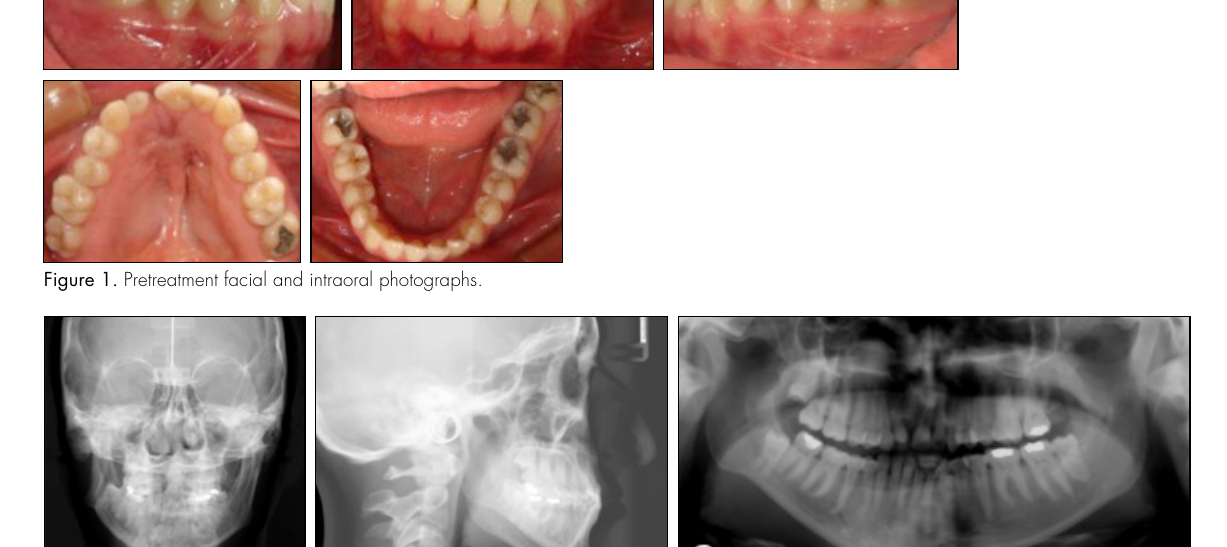
Figure 2. Pretreatment radiographs: A, posteroanterior cephalogram; B, lateral cephalogram; C, panoramic